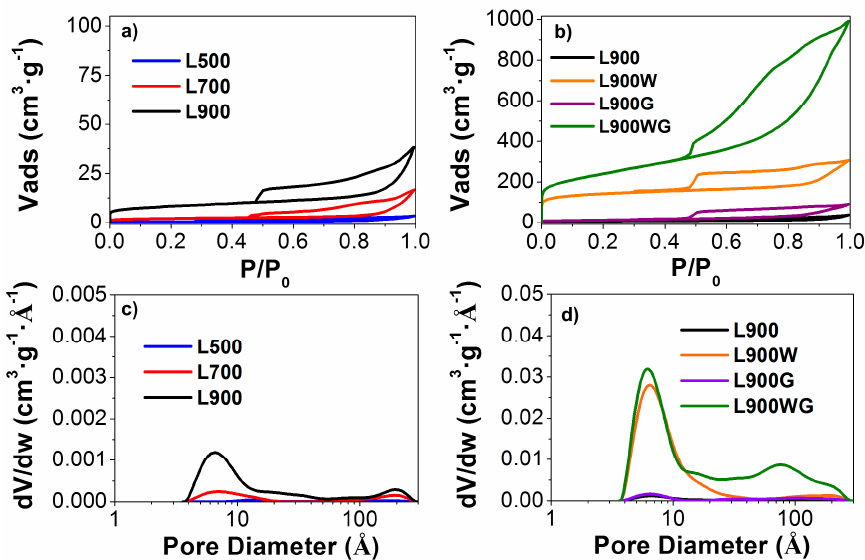
Figure 1. N 2 adsorption-desorption isotherms at − 196 ◦ C of ( a ) the carbon catalysts obtained at different carbonization temperatures and ( b ) the series of carbons prepared at 900 ◦ C. Micropore size distributions of ( c ) the carbon catalysts obtained at different carbonization temperatures and ( d ) the series of carbons prepared at 900 ◦